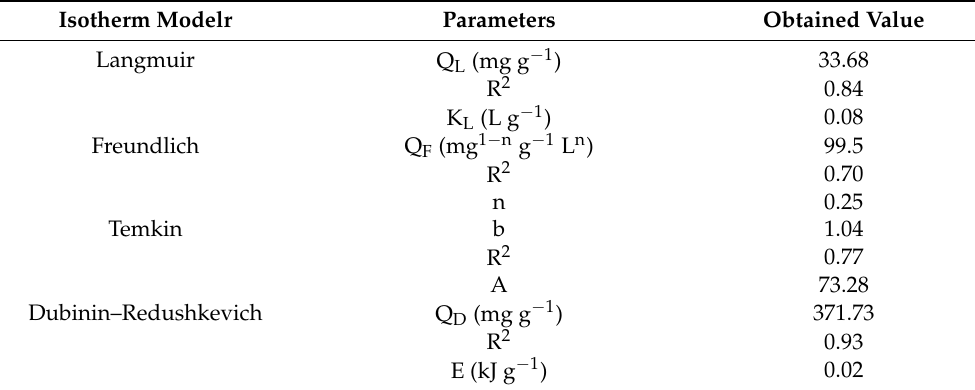
Table 2. Parameters of isotherm modeling for Cr(VI) elimination by rice